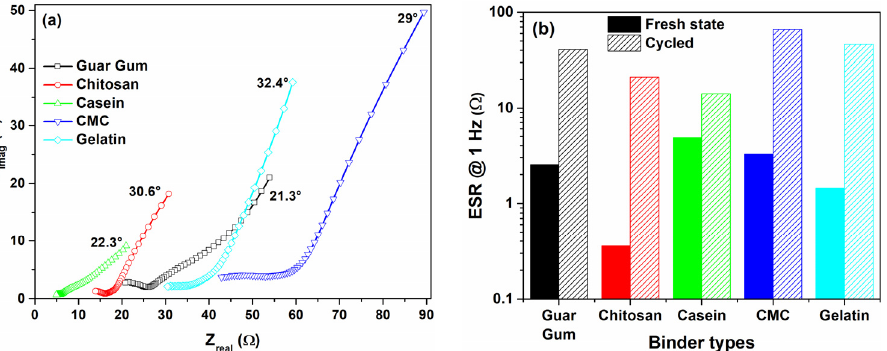
Figure 10. ( a ) Nyquist plots of the supercapacitors investigated after the cycling procedure; ( b ) Comparison of the ESR value at 1 Hz as a function of the binder types extracted from the impedance spectra for the fresh and the cycled devices, respectively.